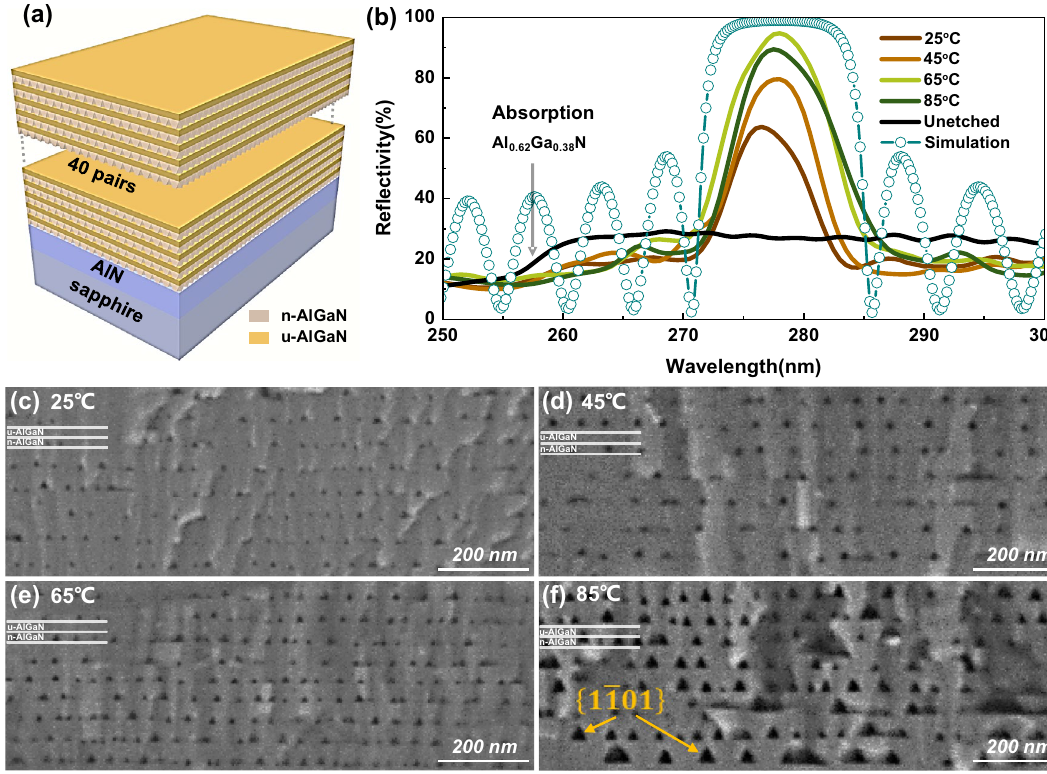
Figure 1. ( a ) Schematic structure; ( b ) The reflectivity spectra of DBRs prepared at 25 V DC bias in KOH electrolytes at different electrolyte temperatures, unetched sample and simulation at 65 °C; Cross-sectional SEM images of the DBRs etched at 25 V in KOH solution at ( c ) 25 °C, ( d ) 45 °C, ( e ) 65 °C and ( f ) 85